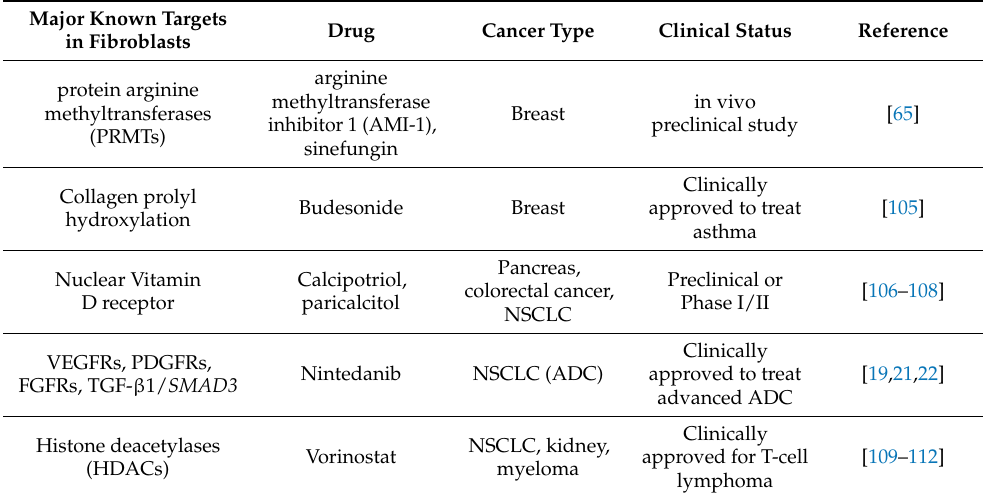
Table 1. List of major drugs that benefit from the aberrant epigenetic reprogramming of